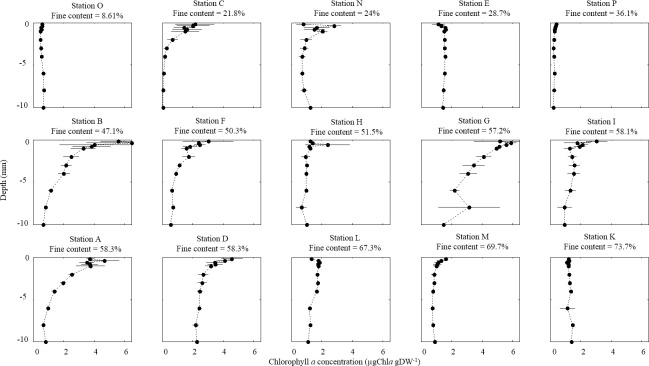
Vertical depth profile of chl a (μg gDW-1) at each sampling site in September 2014.Horizontal bars represent the standard deviation (n = 3).